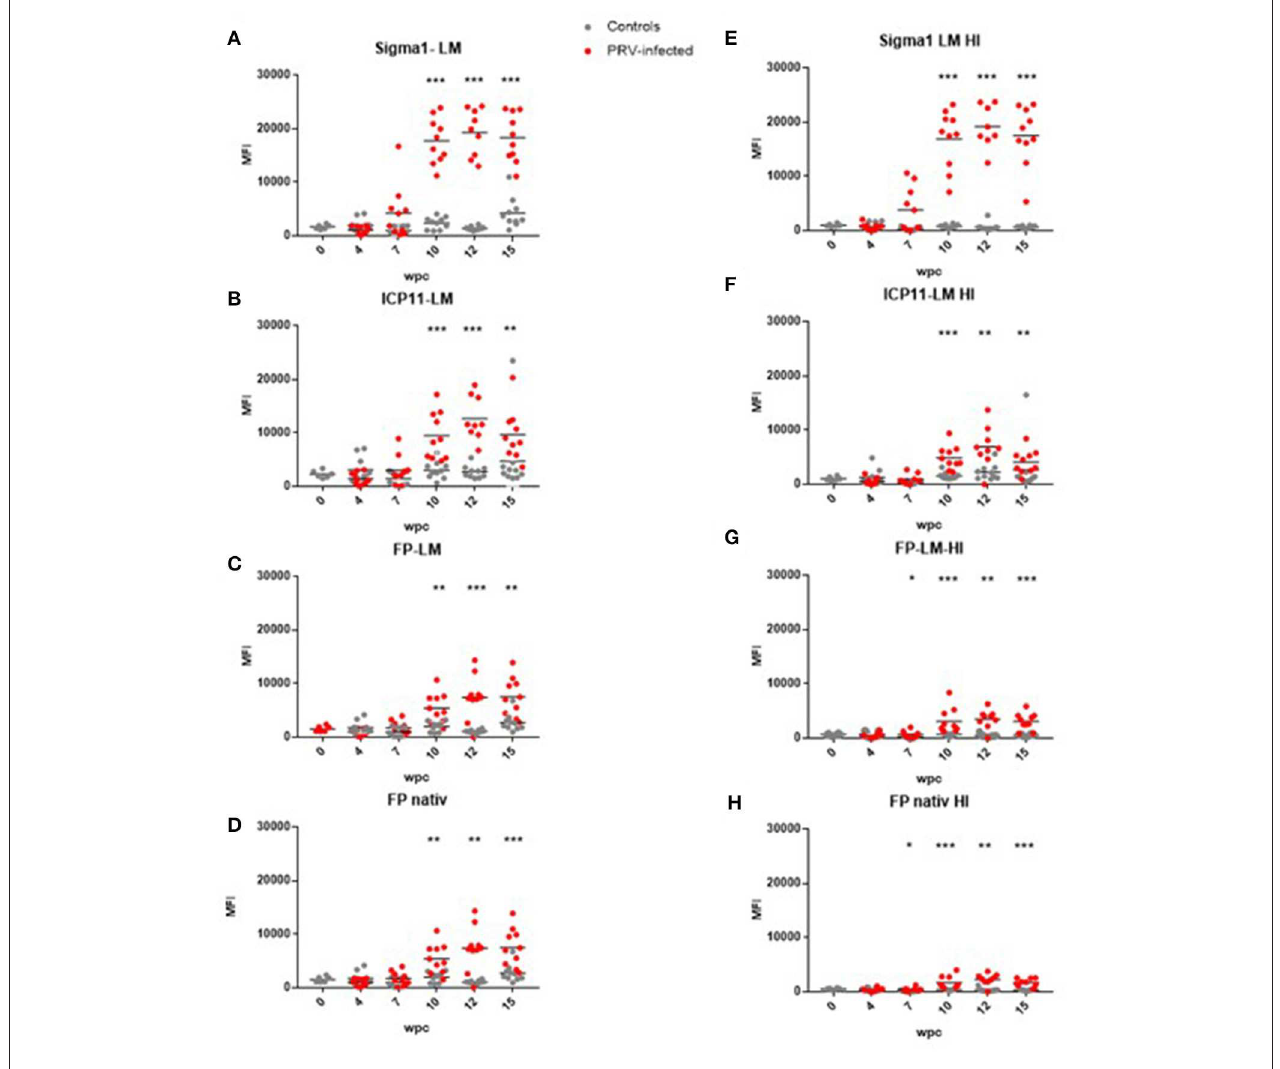
FIGURE 3 | Antibody detection in untreated and heat-treated plasma. (A) LM-PRV σ 1 on untreated plasma. (B) LM-WSSV-ICP11 on untreated plasma. (C) LM-ISAV-FP on untreated plasma. (D) ISAV-FP on untreated plasma. (E) LM-PRV σ 1 on heat-treated plasma. (F) LM-WSSV-ICP11 on heat-treated plasma. (G) LM-ISAV-FP on heat-treated plasma. (H) ISAV-FP on heat-treated plasma. Significant difference between groups are indicated by asterisks (Mann-Whitney test).